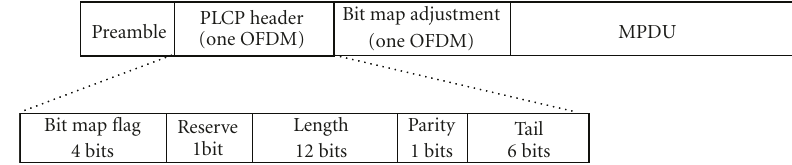
Figure 2: OFDM symbol of Bit Map adjustment in CTS